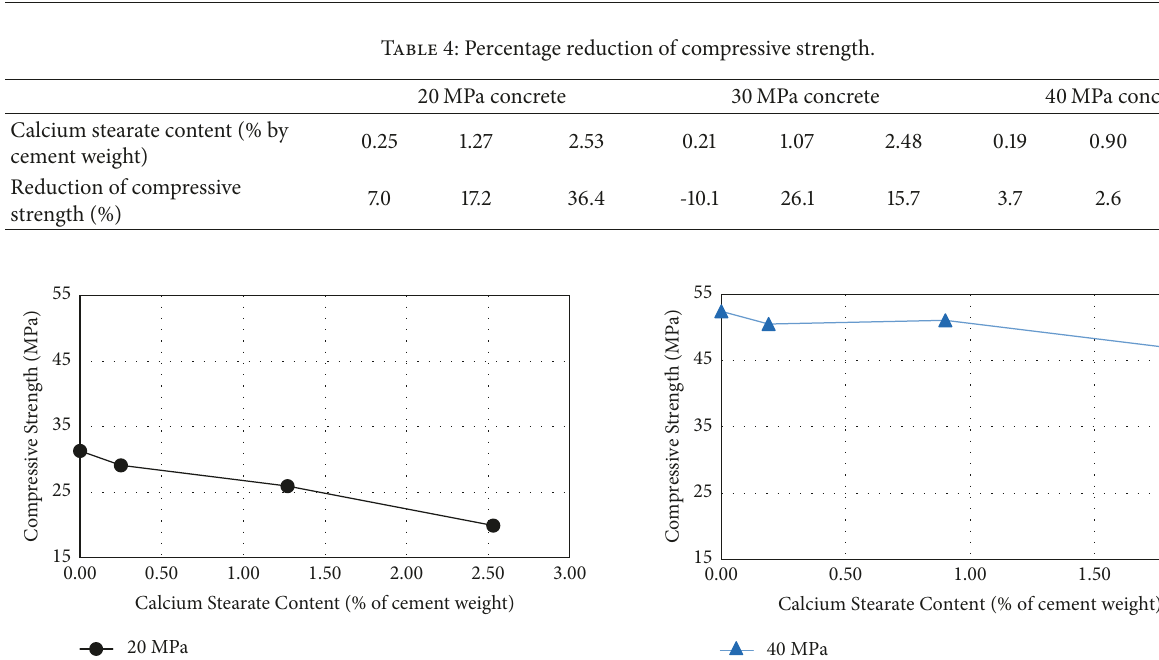
Figure 6: The compressive strengths of concrete grade 20 MPa.